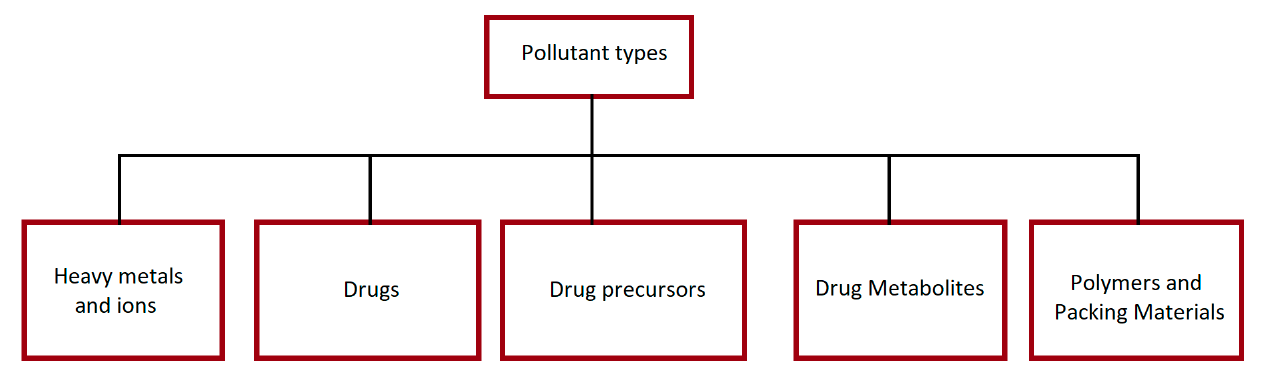
Figure 1. Classification of possible pollutants in PWW.